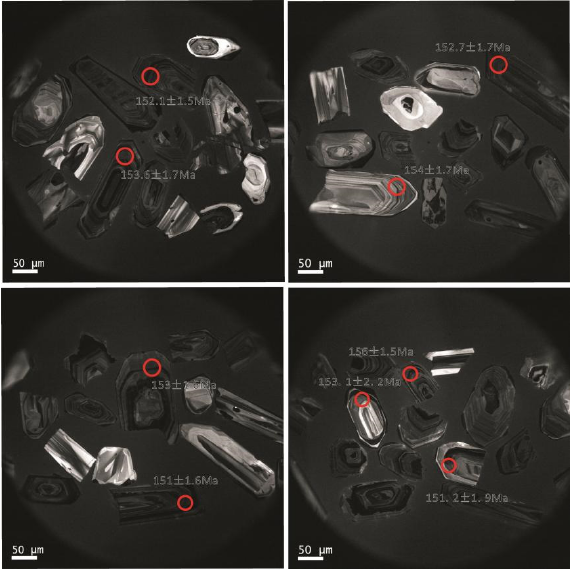
Figure 6. CL images of selected dated zircons from granite porphyry. The red circles and nearby numbers indicate the spot locations and concordant ages.